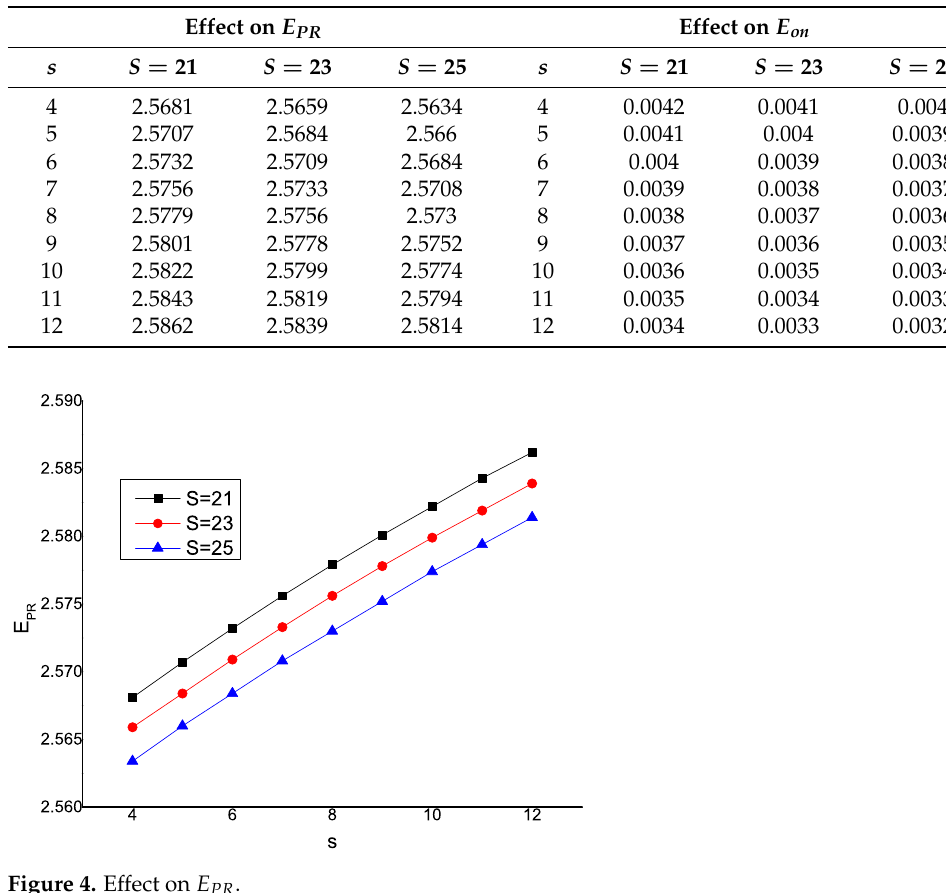
Figure 4. Effect on E PR .